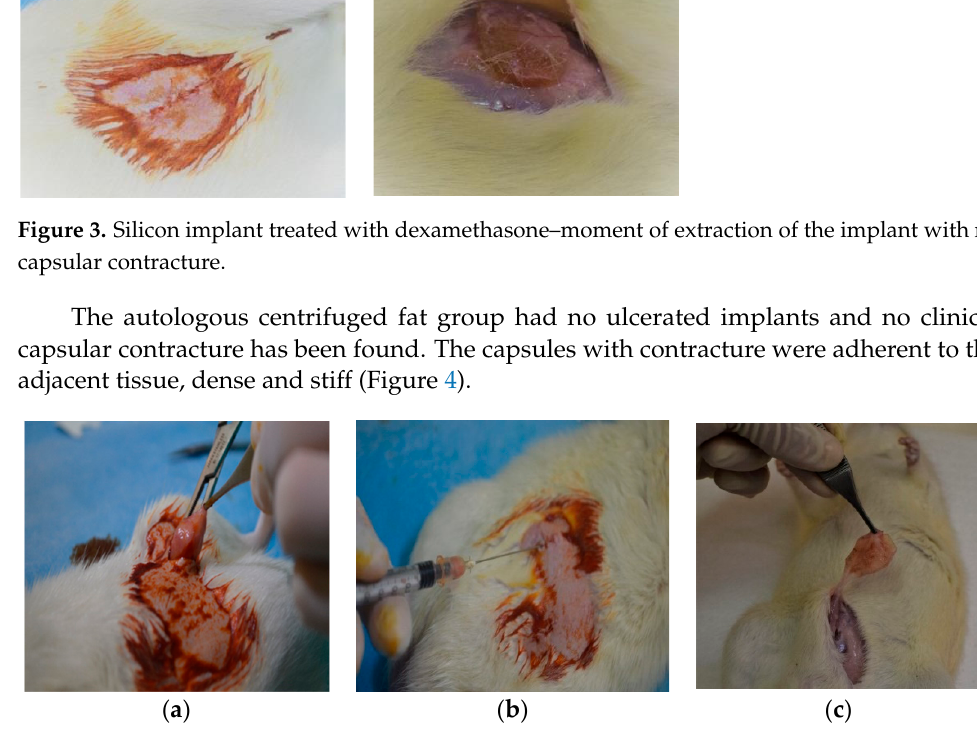
Figure 4. Silicon implant treated with autologous centrifugated fat ( a ) moment of insertion and fat harvesting; ( b ) fat injection in the implant pocket; ( c ) moment of extraction of the implant with no capsular contracture.